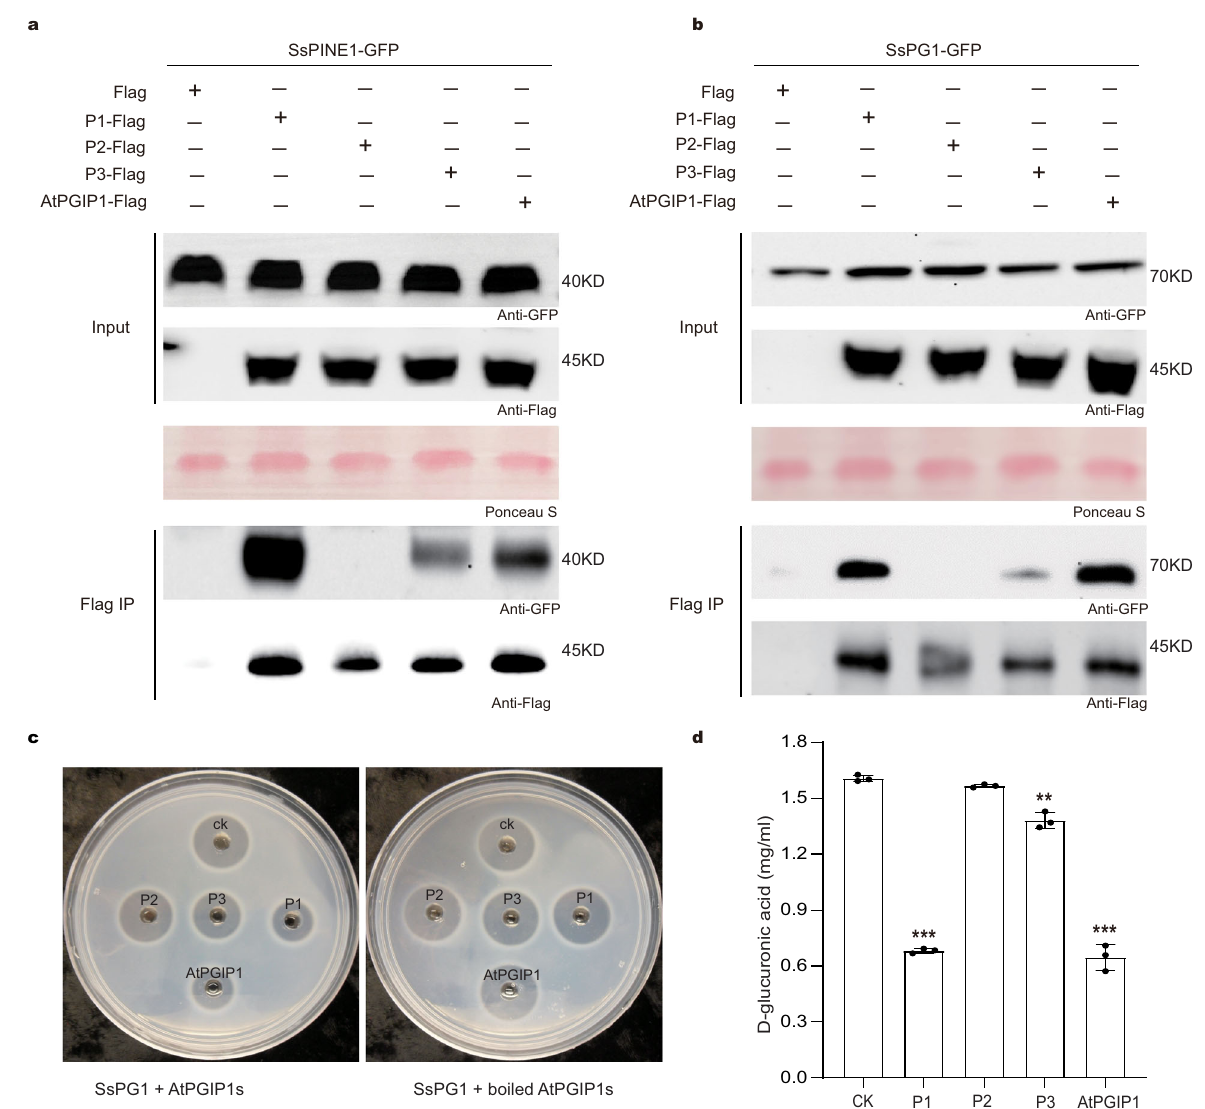
Fig. 5 The P2 region of AtPGIP1 determines its binding speci fi city with SsPINE1 and SsPG1. a Co-IP assays showing the AtPGIP1 variants P2 and P3 have lost and reduced, respectively, af fi nity with SsPINE1. SsPINE1-GFP was co-expressed with 3xFlag-tagged AtPGIP1, AtPGIP1-P1, AtPGIP1-P2, or AtPGIP1-P3 in N. benthamiana leaves. The samples were then used for Flag IPs and anti-GFP Western blots. b Similar Co-IP assays were carried out to test the bindings of SsPG1-GFP to 3xFlag-tagged AtPGIP1, AtPGIP1-P1, AtPGIP1-P2, or AtPGIP1-P3. Co-IP assays showing the AtPGIP1 variants P2 and P3 have lost and reduced af fi nity with SsPG1, respectively. SsPG1-GFP was co-expressed with 3xFlag-tagged AtPGIP1, AtPGIP1-P1, AtPGIP1-P2, or AtPGIP1-P3 in N. benthamiana leaves. The samples were then used for Flag IPs and anti-GFP Western blots. c Agar diffusion assay showing the SsPG1-inhibitory activity of AtPGIP1 and its mutation variants P1, P2 and P3. The wells were applied with 0.5 μ g of SsPG1 alone (CK) and with 10 μ g of either variant P1, P2, P3, or wildtype AtPGIP1 proteins. d PG activity of SsPG1 alone (CK) and in the presence of AtPGIP1 or its mutation variants were determined by measuring the released D-galacturonic acid. Data represent means ± s.d. of n = 3 independent replicates. ** and *** indicate signi fi cant difference from the check (CK, SsPG1 alone) at p < 0.01 and 0.001, respectively, in two-tailed t-test. Source data are provided as a Source data fi le. SsPINE1 lowers plant immunity . Stable 35S:: SsPINE1-GFP and The three genotypes (Col-0, 35S::SsPINE1 and 35S::AtPGIP1) 35S:: AtPGIP1-3xFlag Arabidopsis (Col-0) overexpressing lines of A. thaliana plants were tested for their reactions to infection by were created to investigate in planta the roles of SsPINE1 and three genotypes of S. sclerotiorum (wild-type, Δ SsPINE1 and Δ SsPG1 ) strains. Deletion of either SsPINE1 or SsPG1 signi fi - AtPGIP1 in plant- Sclerotinia interactions. Expression of SsPINE1- GFP in A. thaliana was con fi rmed by Western blot and fl uores- cantly reduced S. sclerotiorum virulence (Fig. 6), with the disease cence microscopy (Supplementary Fig. 9a, b), and overexpression lesion sizes on Col-0 plants reduced by around 30% and 95%, of AtPGIP1-3xFlag was con fi rmed by Western blot and RT-qPCR respectively. In general, ectopic expression of SsPINE1 increased (Supplementary Fig. 9c, d). The AtPGIP-3xFlag protein was A. thaliana susceptibility to all three genotypes of S. sclerotiorum detected in the apoplastic fl uid (Supplementary Fig. 9e), sug- (Fig. 6a, b). Compared to wild-type A. thaliana (Col-0), plants gesting that AtPGIP1 is also a secreted protein. All transgenic expressing SsPINE1 ( 35S::SsPINE1 ) exhibited signi fi cantly lines showed normal growth and morphology (Supplementary increased disease lesion areas and relative Sclerotinia biomass Fig. 9f). upon S. sclerotiorum (WMA1, Δ SsPINE1 or Δ SsPG1 ) infection NATURE COMMUNICATIONS| (2022) 13:2213